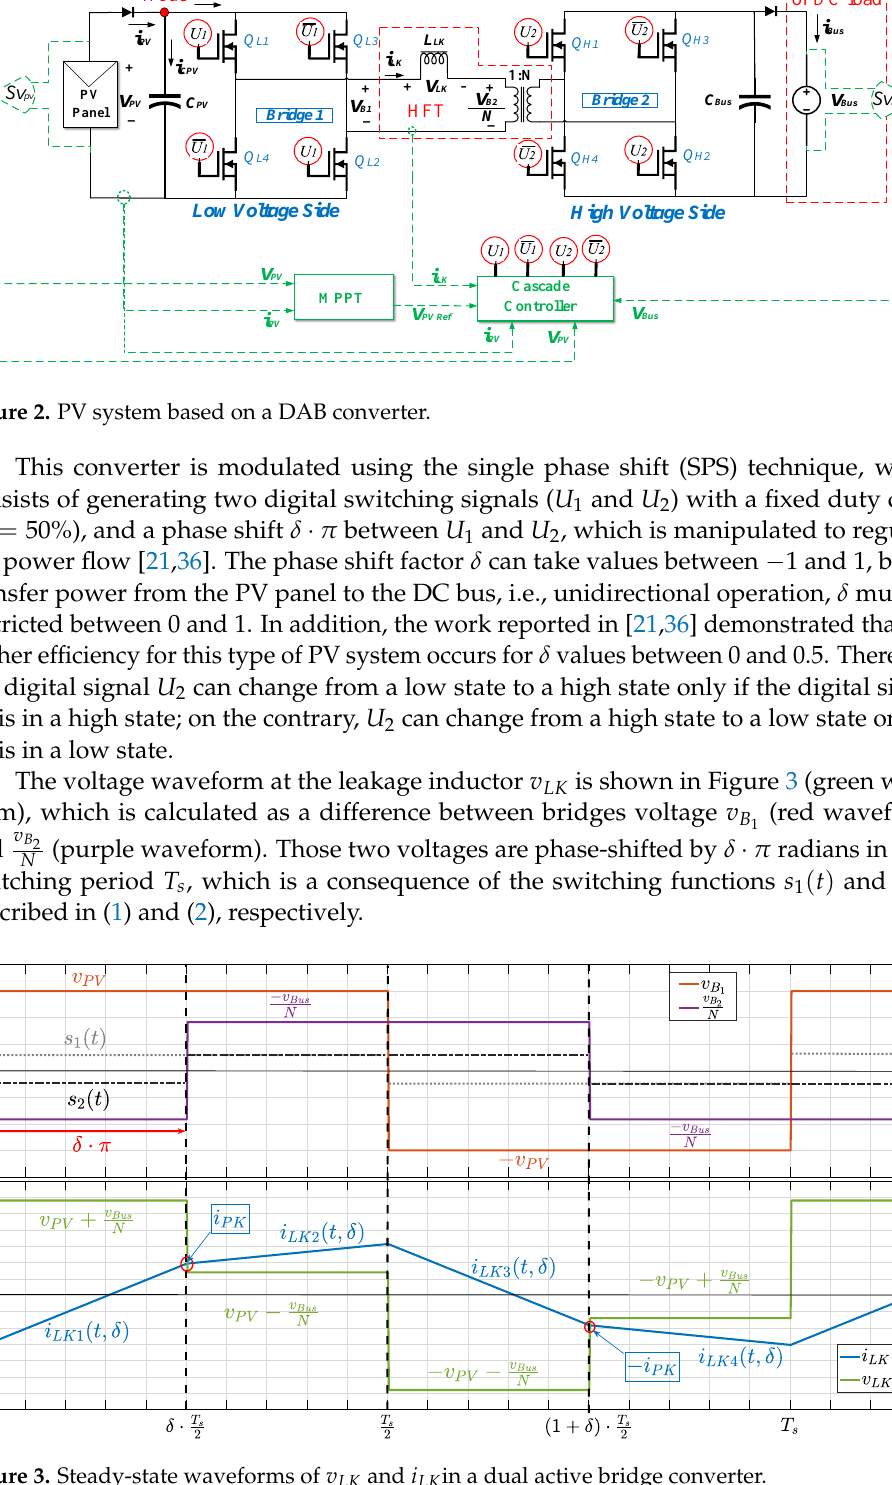
Figure 3. Steady-state waveforms of v LK and i LK in a dual active bridge